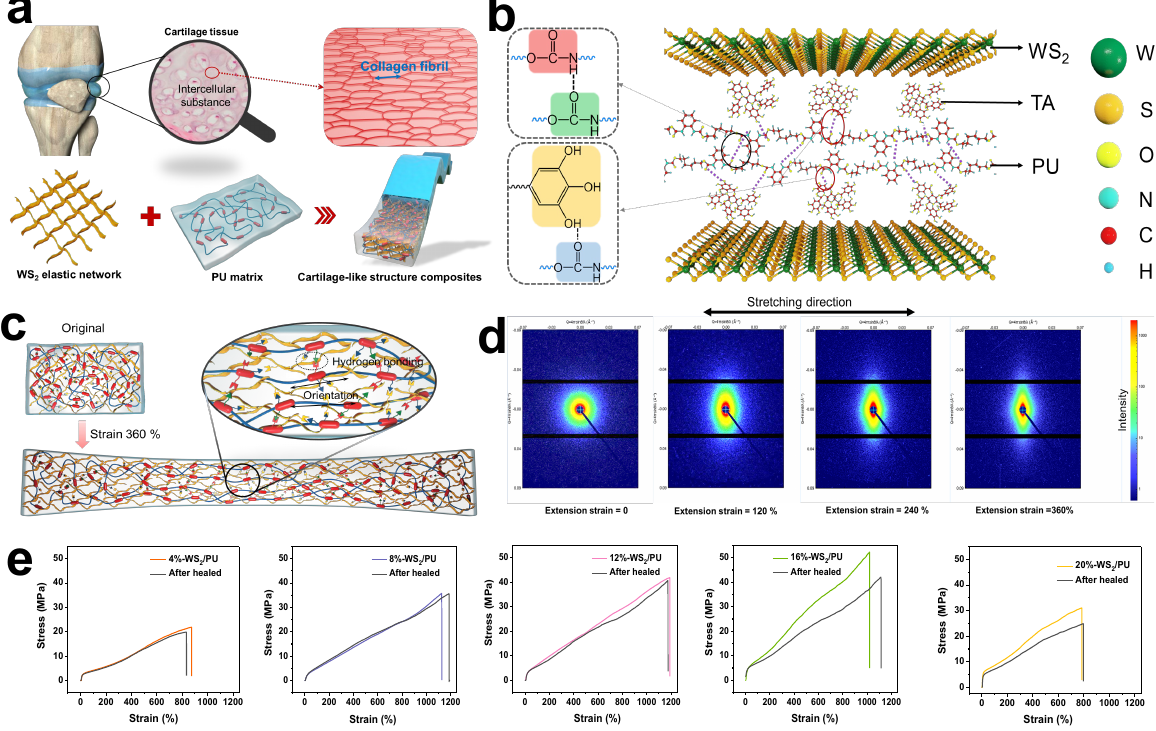
Figure 8. ( a ) Schematic illustrations of a cartilage structure, intercellular substance of cartilage tissue and the nanostructure of composite consisting of hydrogen-bonded interwoven network of 2D WS 2 and PU matrix. ( b ) Schematics of the dynamic noncovalent bonding interaction between PU and interwoven network of 2D WS 2 . ( c ) Schematic illustrations of the nanostructure of the original sample and stretching sample. ( d ) 2D SAXS images of the 16 wt% TA-WS 2 /PU with different tensile strain during uniaxial stretching process. ( e ) Mechanical self-healing performance of PU composites filled with different contents of TA-WS 2 . Reproduced with permission [177]. Copyright 2021 Springer